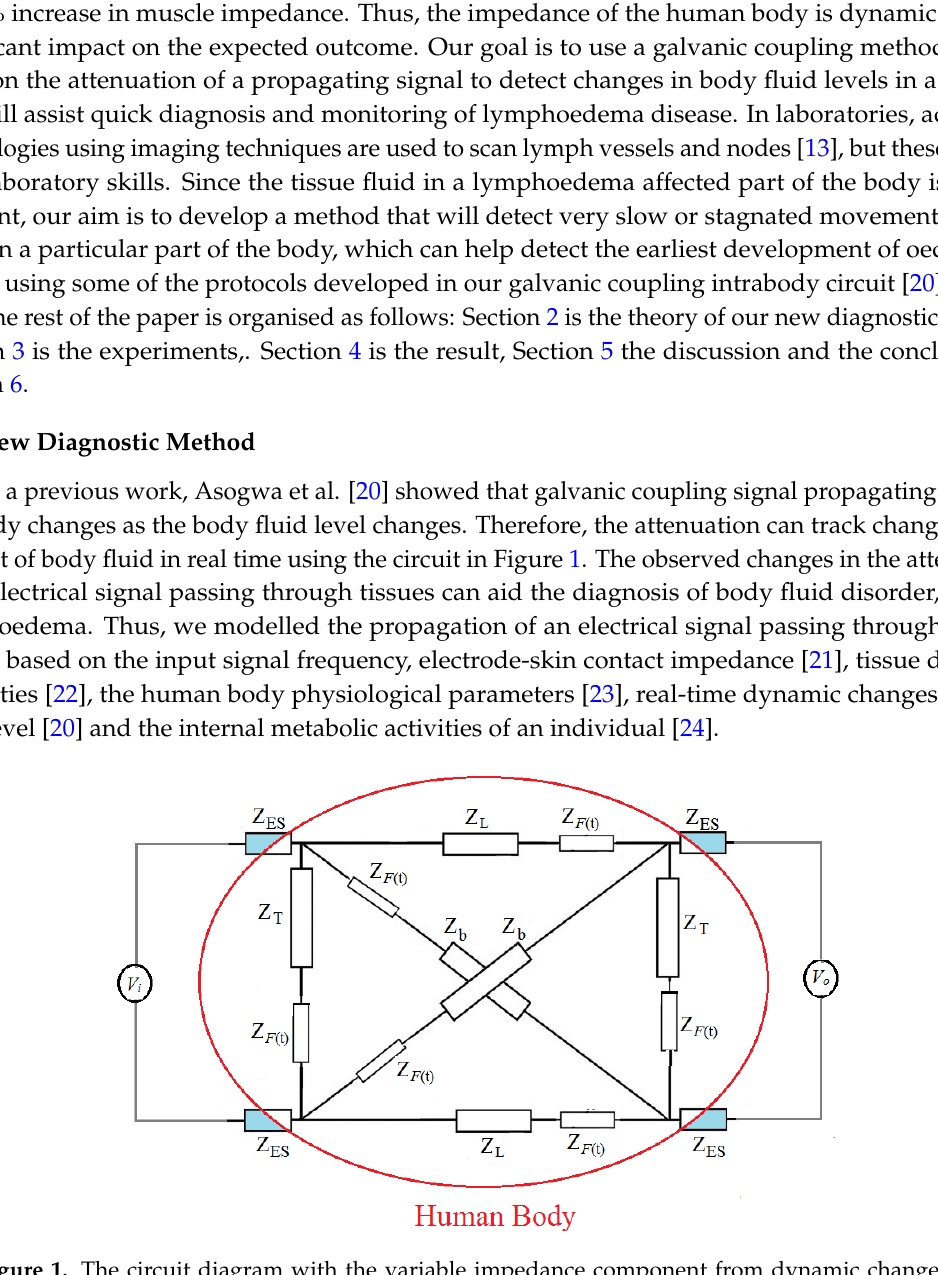
Figure 1. The circuit diagram with the variable impedance component from dynamic changes in human body fluid volume. Reproduced with permission from [20], IEEE,